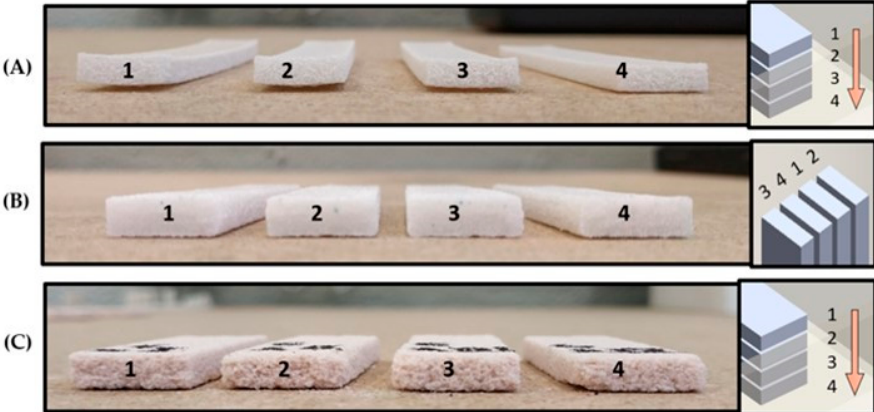
Figure 6. Representative example batches of specimens and their relative positions inside the cruci- ble. ( A ) Horizontal specimens. ( B ) Vertical specimens. ( C ) Horizontal specimens with 60% sand in weight.